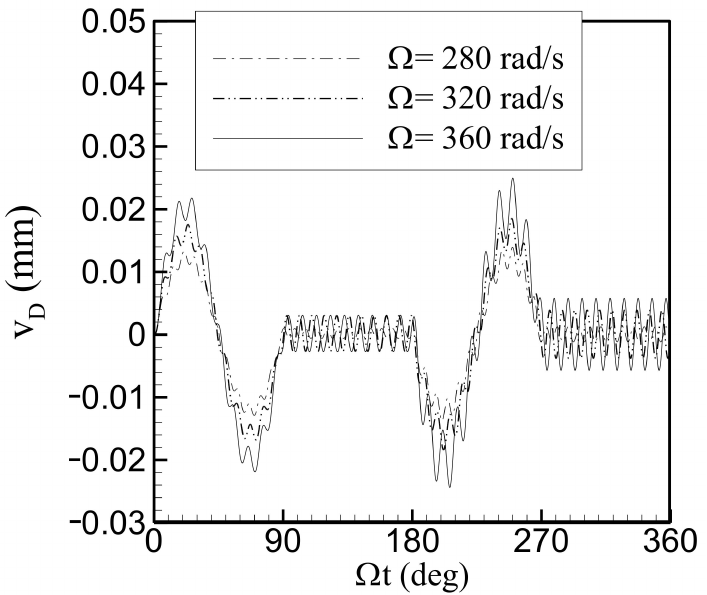
Figure 6. The time responses of the follower output node D in the lateral direction at three cam speeds: 280, 320, and 360 rad/s.